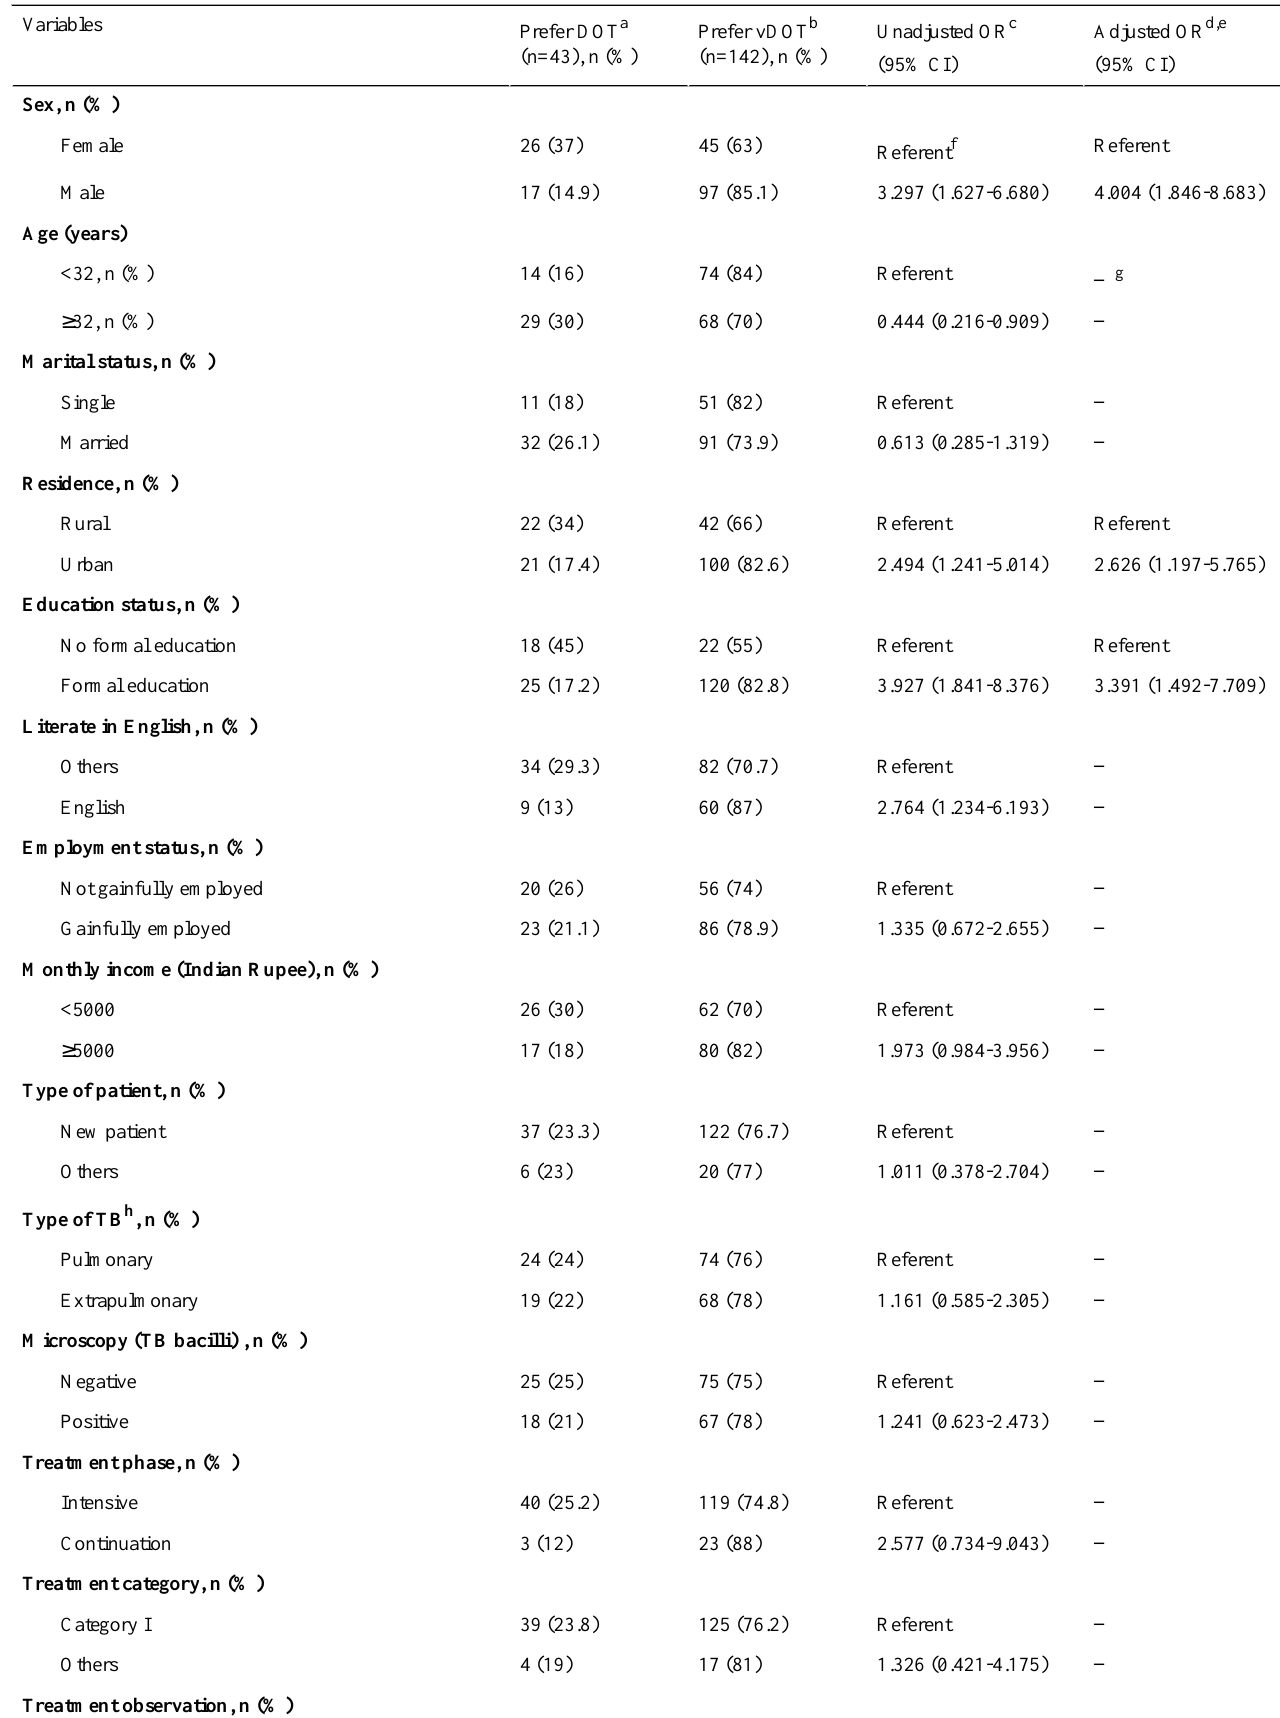
Table 5. Preference for video-based directly observed treatment to in-person directly observed treatment and its association with demographics, clinical details, and mobile phone usage